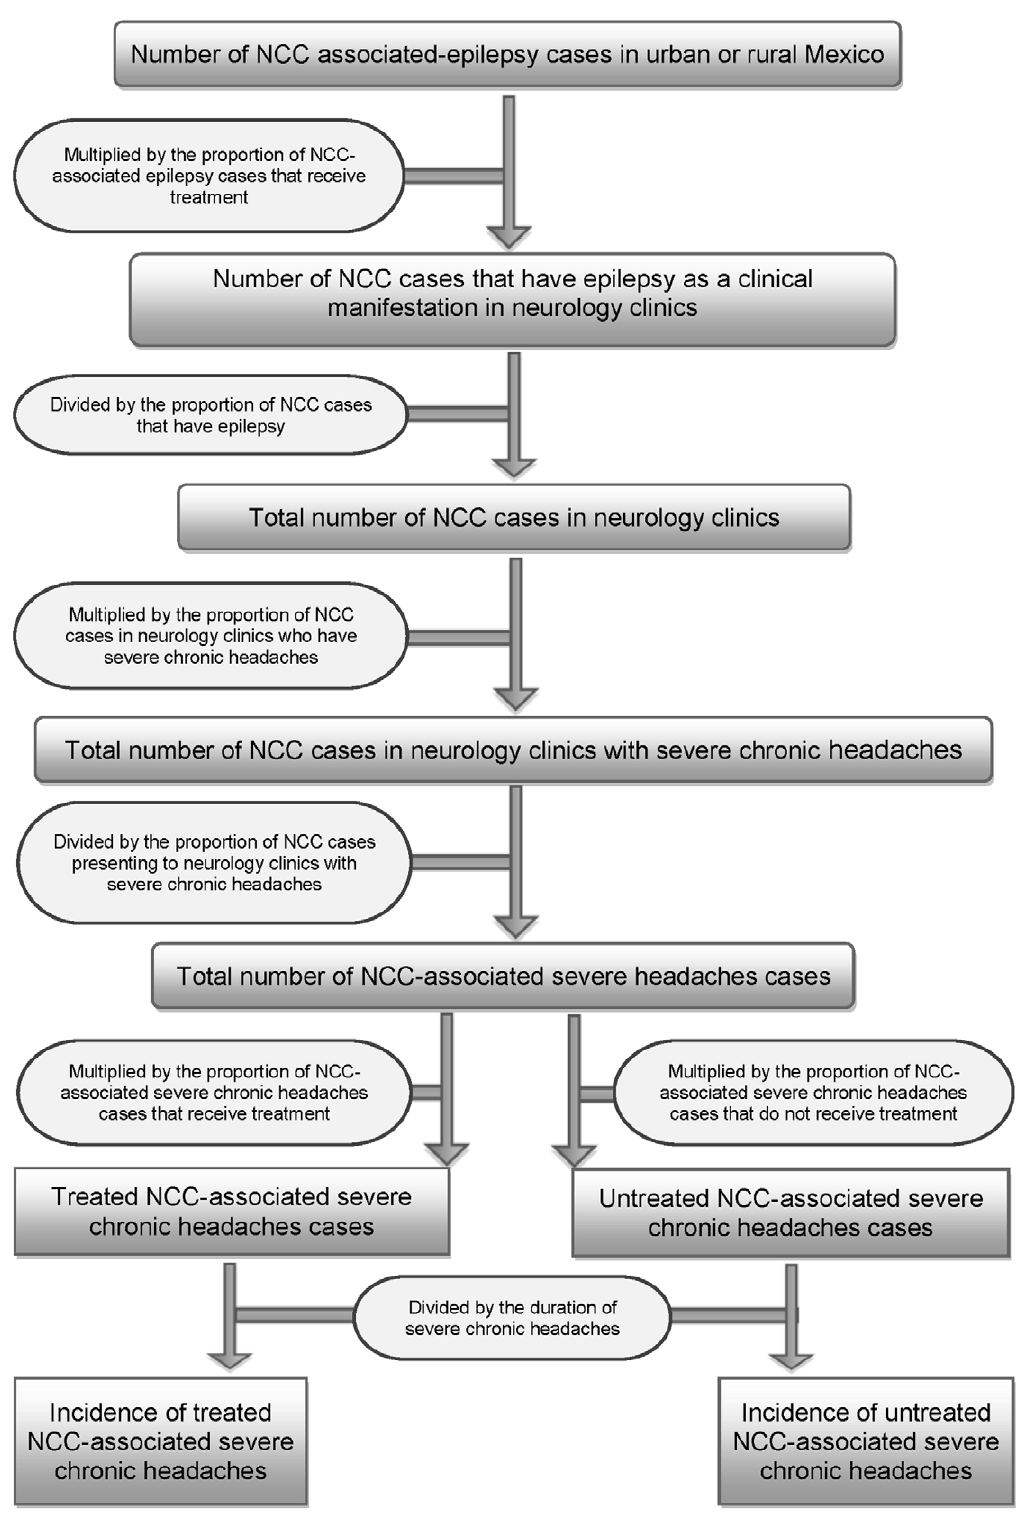
Figure 3. Flowchart for estimating the incidence of NCC-associated severe chronic headaches in Mexico. Note: Please refer to Table 1 for information concerning the uncertainty distributions associated with the specific parameters. All data were stratified by urban/rural residence.